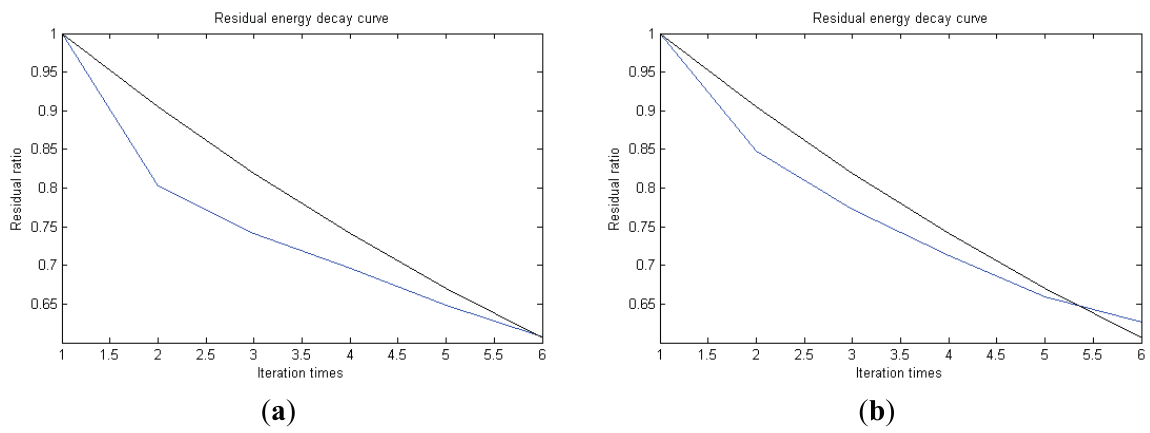
Figure 18. Residual energy decay curve: ( a ) first 512 points; ( b ) last 512 points.